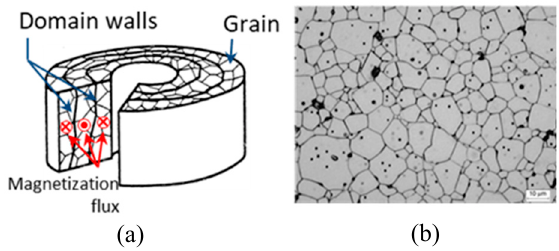
Figure 3. ( a ) The concept of the magnetic torus. ( b ) General aspect of the microstructure of a polycrystalline ferrite, with intragranular and intergranular porosity.